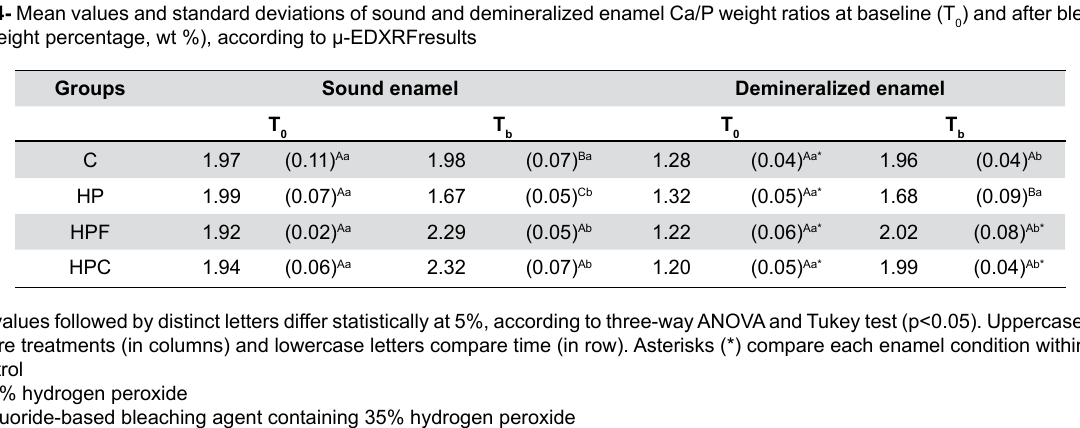
) and after bleaching 0